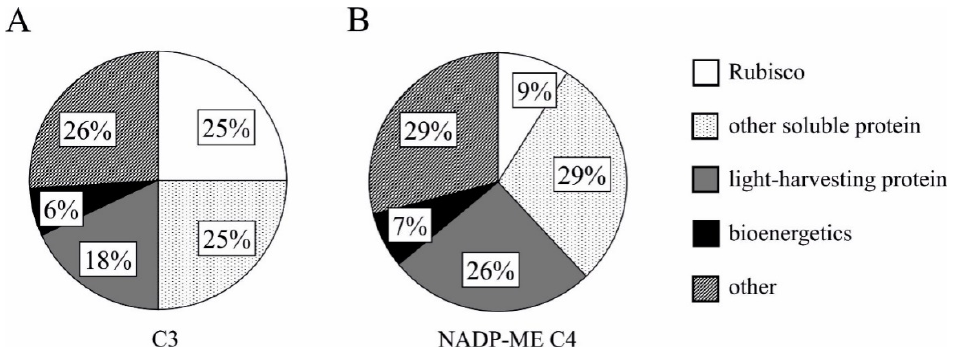
Figure 2. Nitrogen allocation on the percentage of different N components within the leaf in C3 ( A ) and NADP-ME C4 ( B ) plants. Modified by Mu and Chen [17]. and NADP-ME C4 ( B ) plants. Modified by Mu and Chen